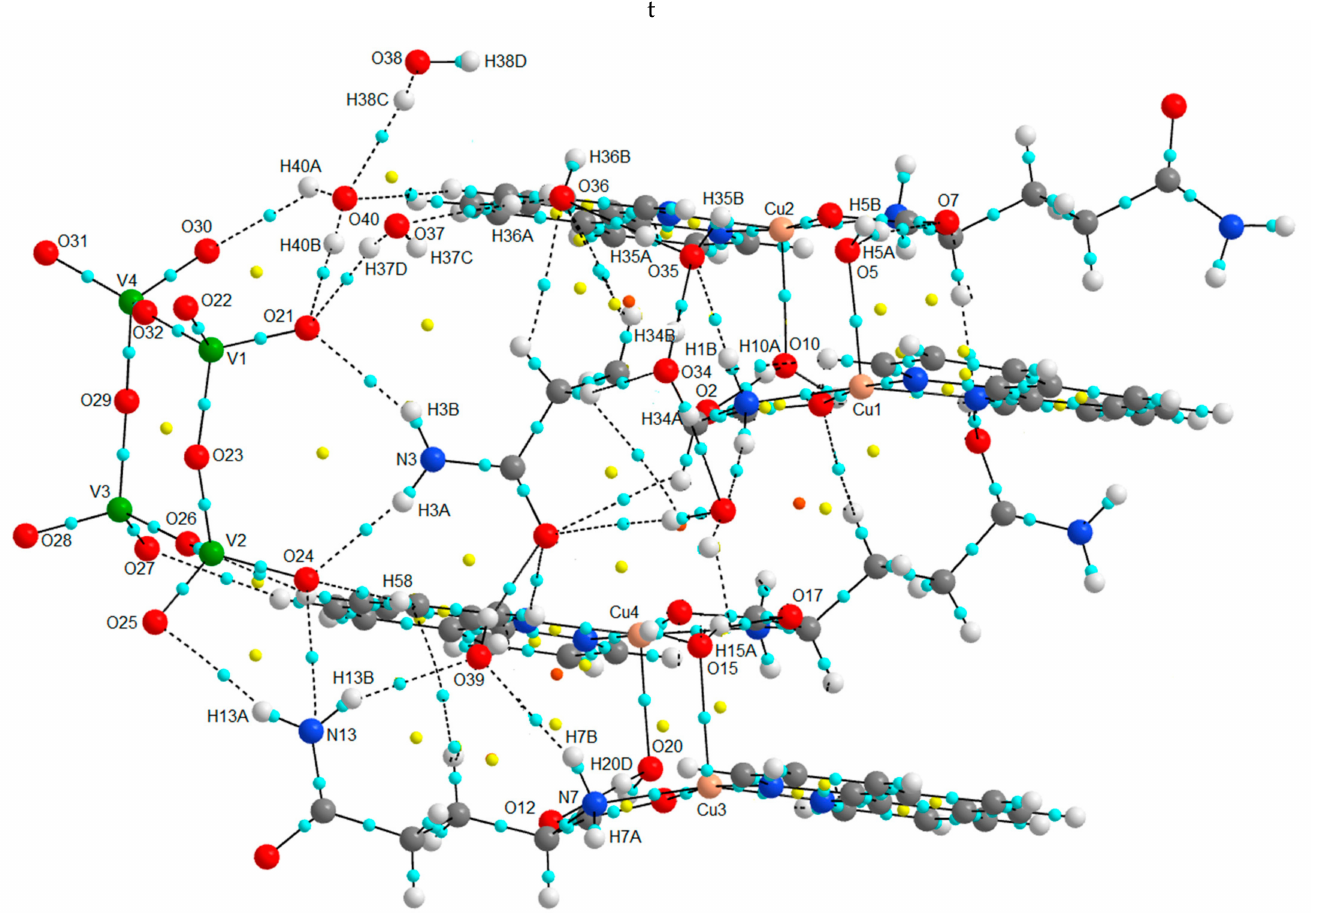
Figure 6. Molecular graph of the Compound 1 showing the main H-bonds between ions.